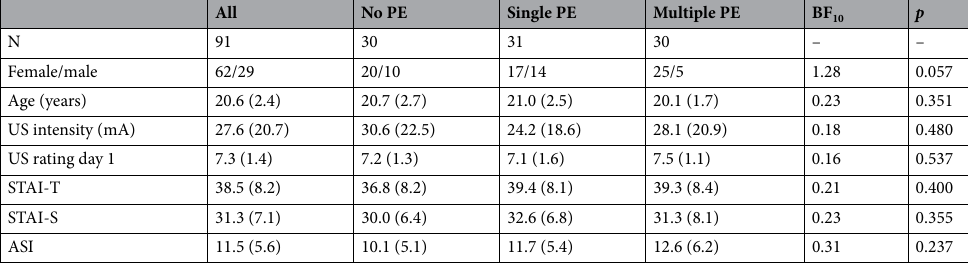
Table 1. Baseline characteristics of all participants combined and within each group separately. Baseline characteristics were compared between groups with a Bayesian chi-square test (sex) and a Bayesian one-way ANOVA (all other). Bayes Factors showing evidence for the existence of a difference between groups are displayed. Successful fear acquisition in all